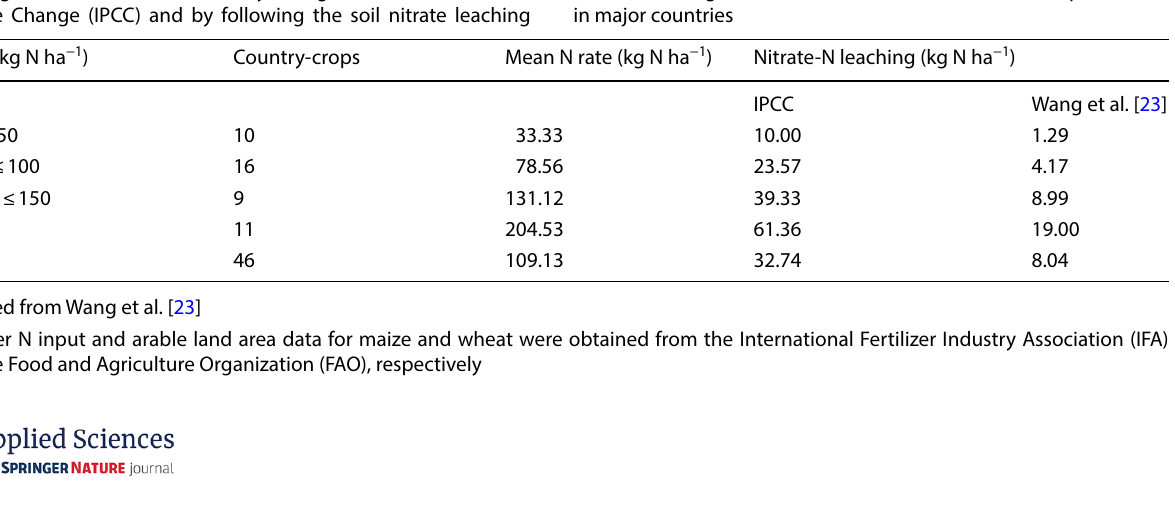
emission factors, which vary with fertilizer N as proposed by Wang et al. [23] for agricultural land under wheat and maize production in major countries